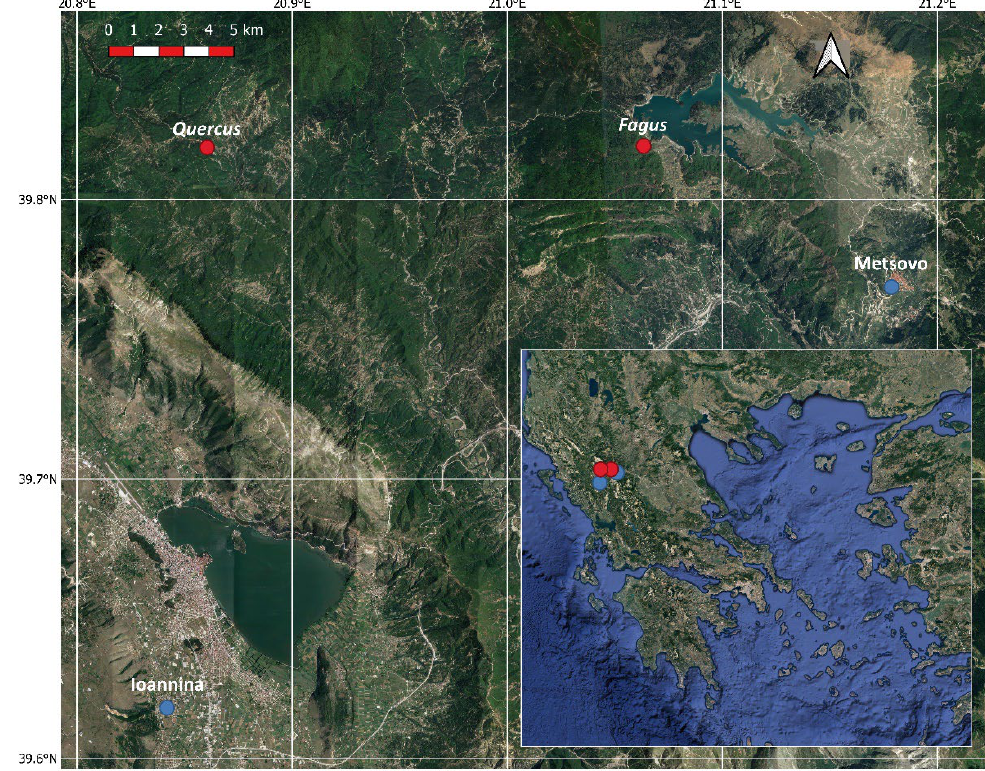
Figure 1. Google Satellite image of the study area, Greece (inset), with the studied sites indicated with red dots and the meteorological stations with blue dots.